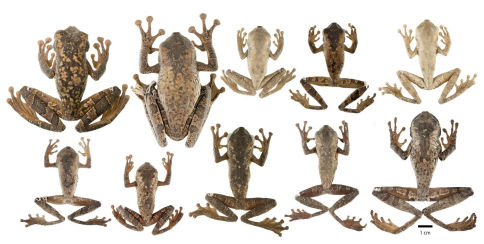
Adult Osteocephalus festae showing variation in dorsal coloration of preserved specimens. Left to right, upper row: QCAZ 39804, 39811, 39810, 39802, 39798 (females); lower row: QCAZ 39799, 26552, 26488, 26561 (males), 39364 (female). Provincia Loja and Morona Santiago, Ecuador. See Appendix I for locality data.